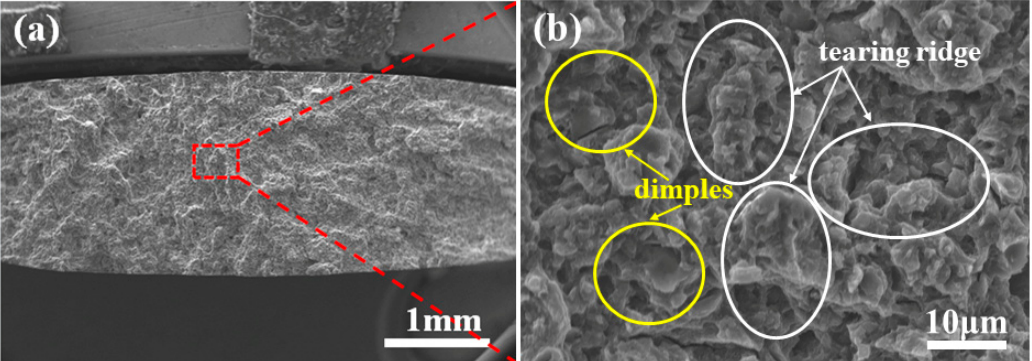
Figure 12. Fracture morphologies of SLM tensile samples: ( a ) the overall fracture surface morphology, ( b ) the local magnification of fracture surface morphology.